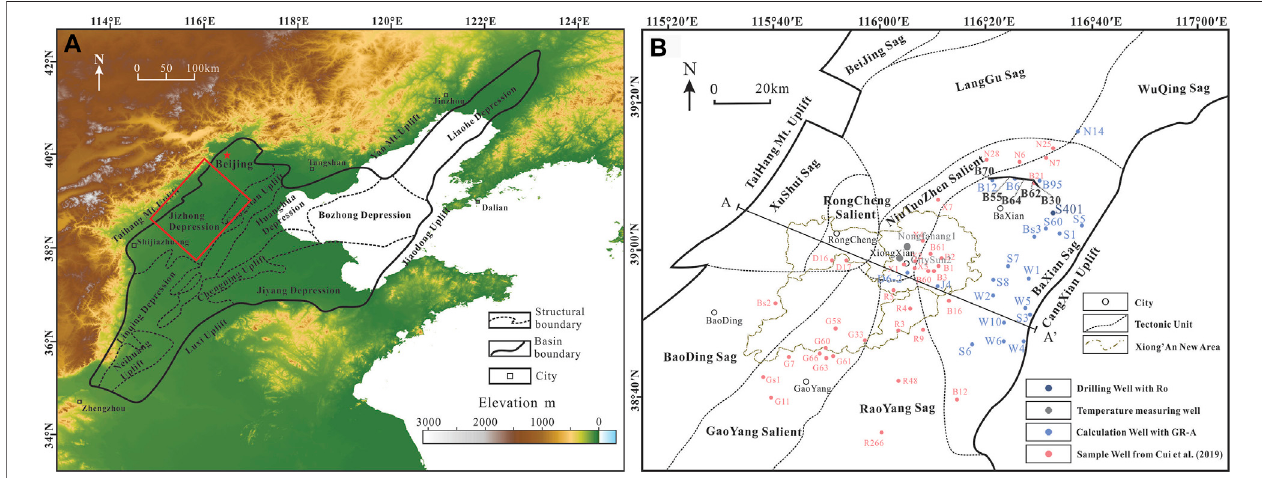
FIGURE 1 | Structural location map of (A) Bohai Bay Basin and (B) Xiong ’ an new area.